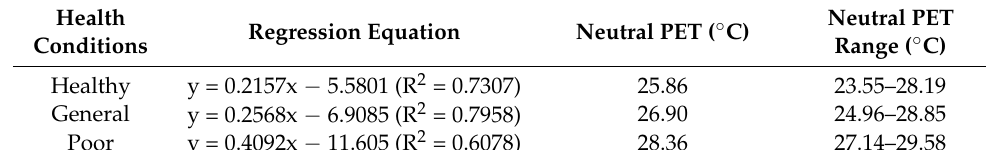
Table 7. NPET and NPETR in elderly with different health conditions.